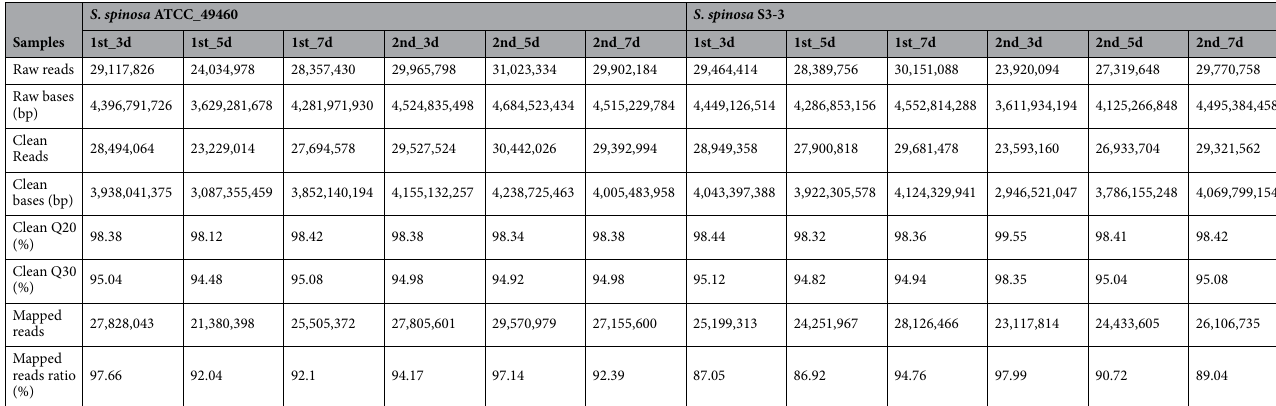
Table 1. Statistical analysis of sequence data and genome